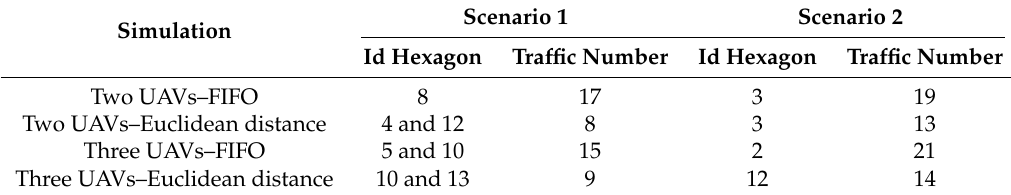
Table 1. Hexagon traffic.